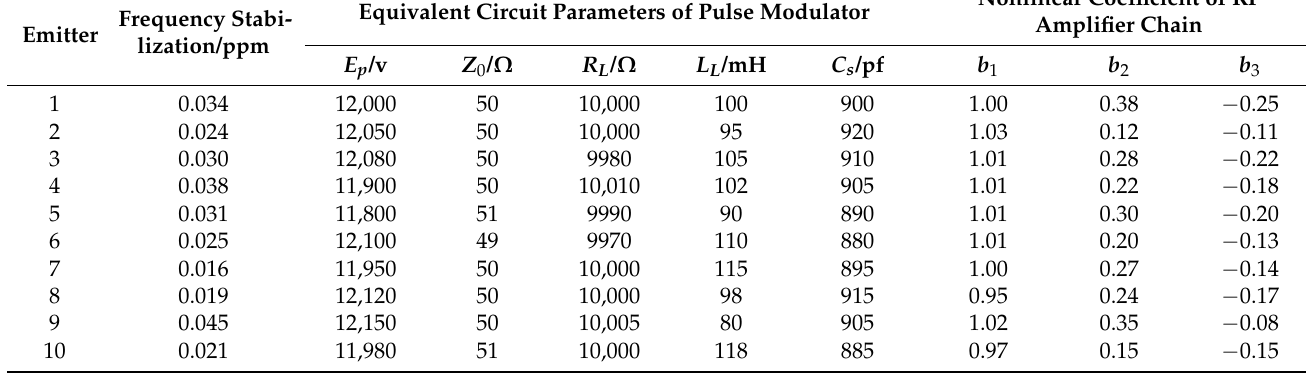
Table 2. Characteristic parameters of 10 simulated